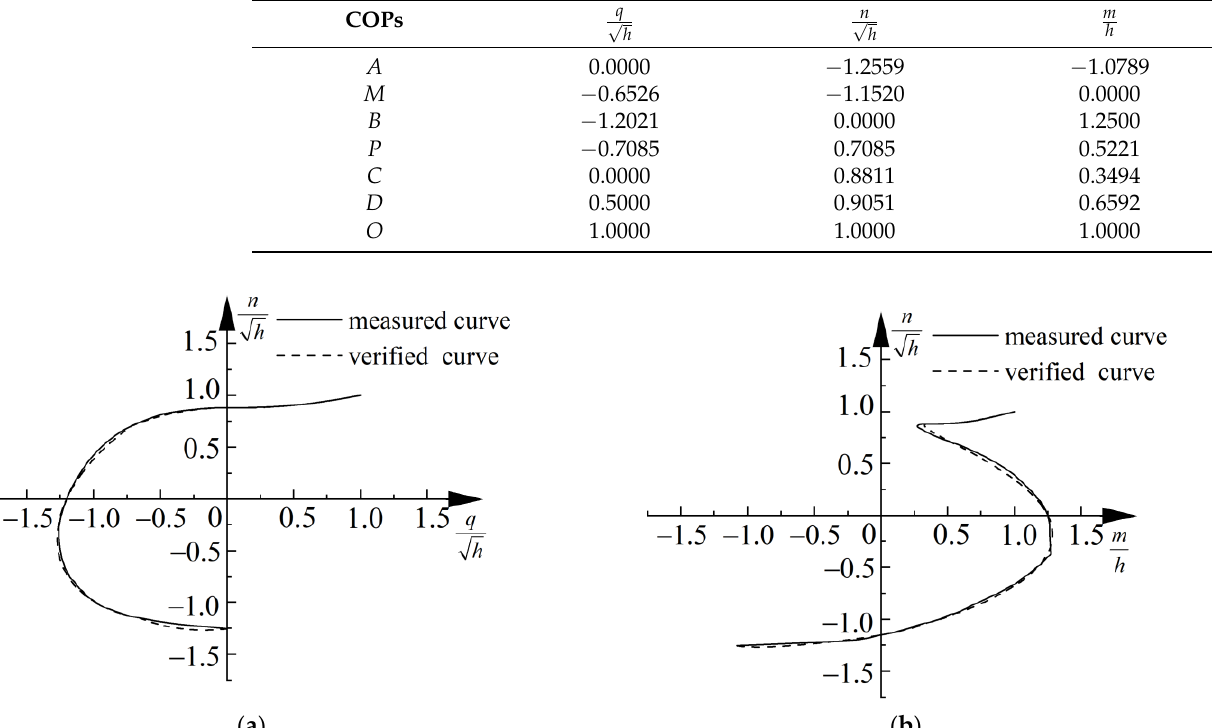
√ √ √ h − n / h curve; ( b ) m / h − n / h